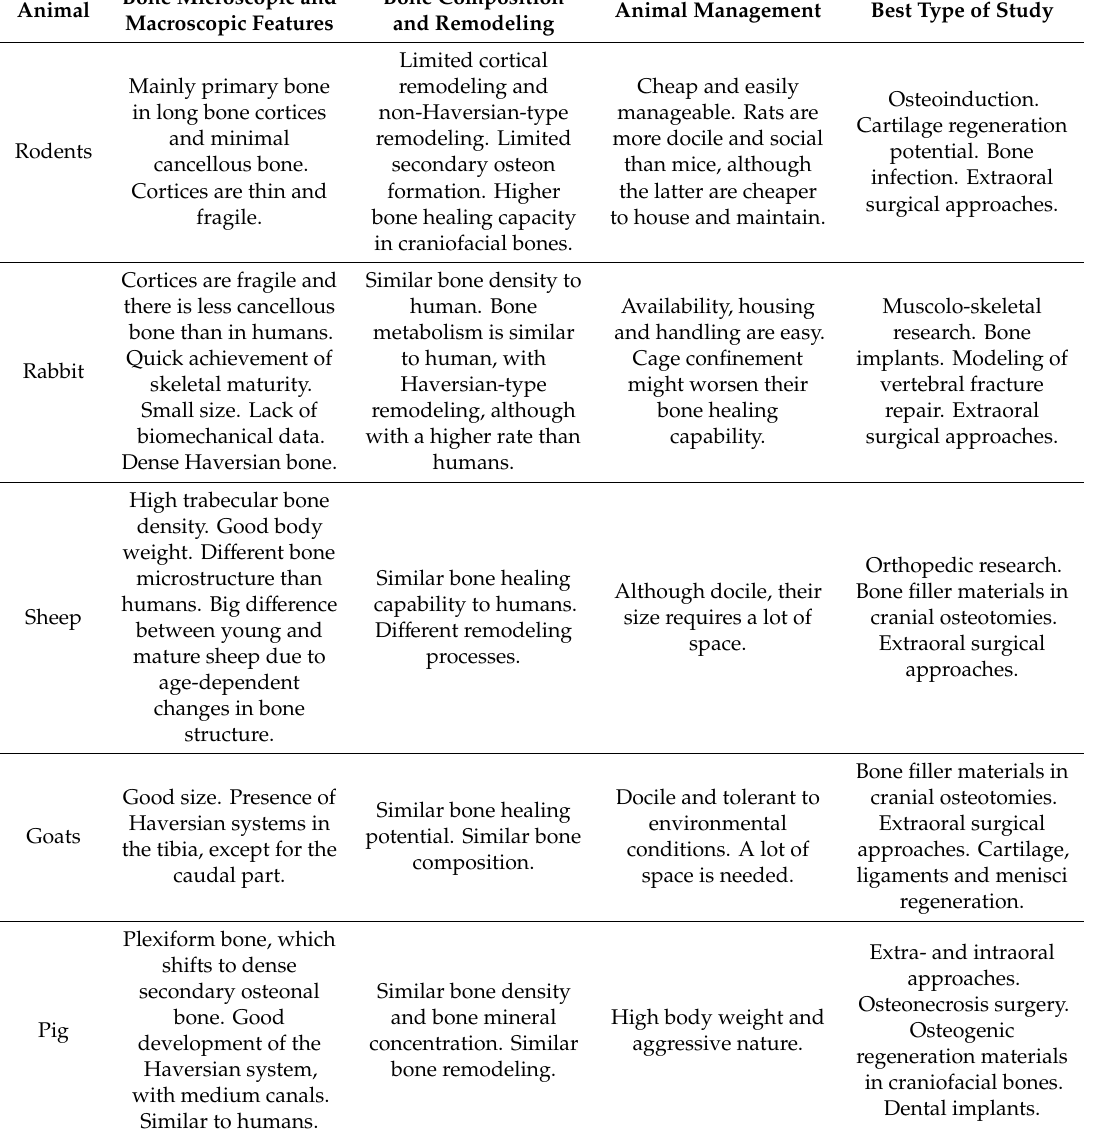
Table 2. Main animal models for bone healing investigation